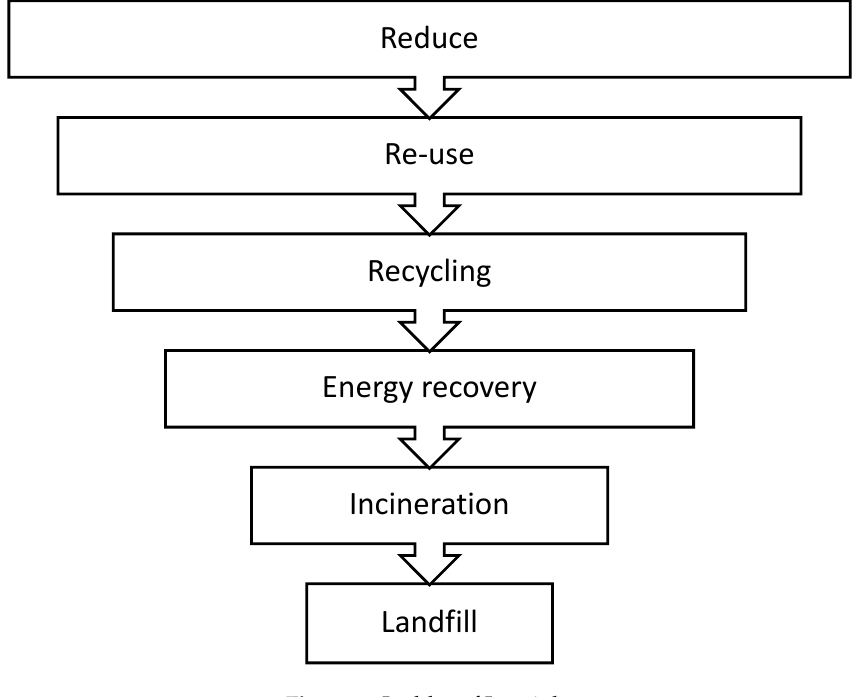
Figure 3. Ladder of Lansink.